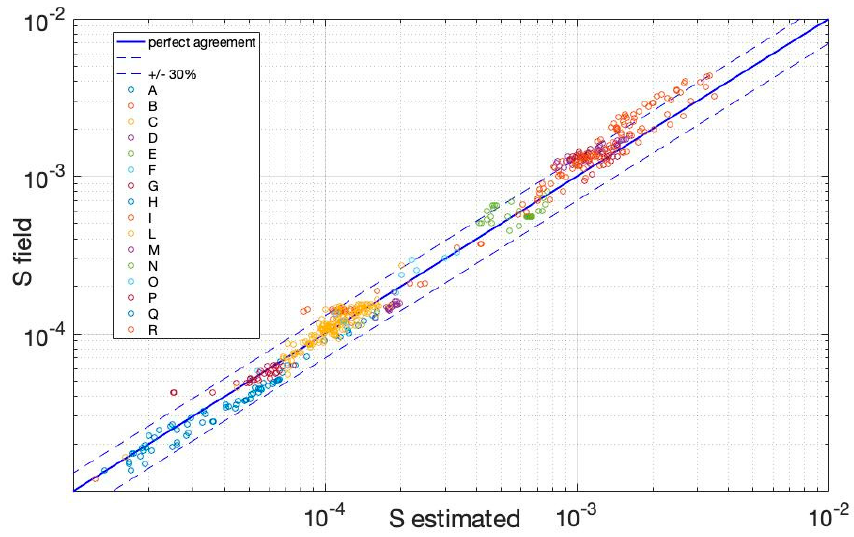
Figure 5. Comparison of estimated and observed total energy slope (the dashed lines represent the ± 30% error